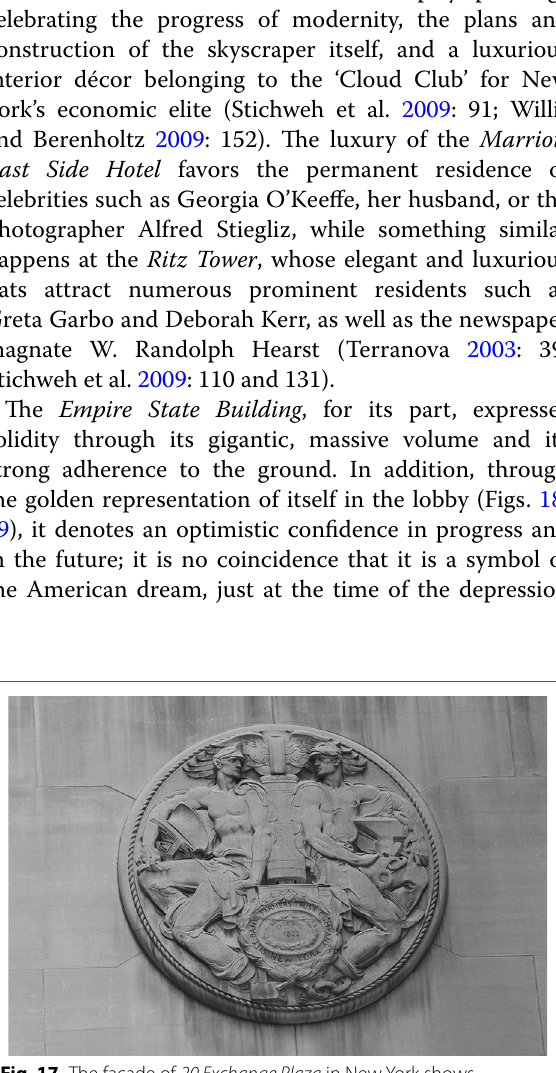
Fig. 17 The façade of 20 Exchange Plaza in New York shows ornaments on agriculture